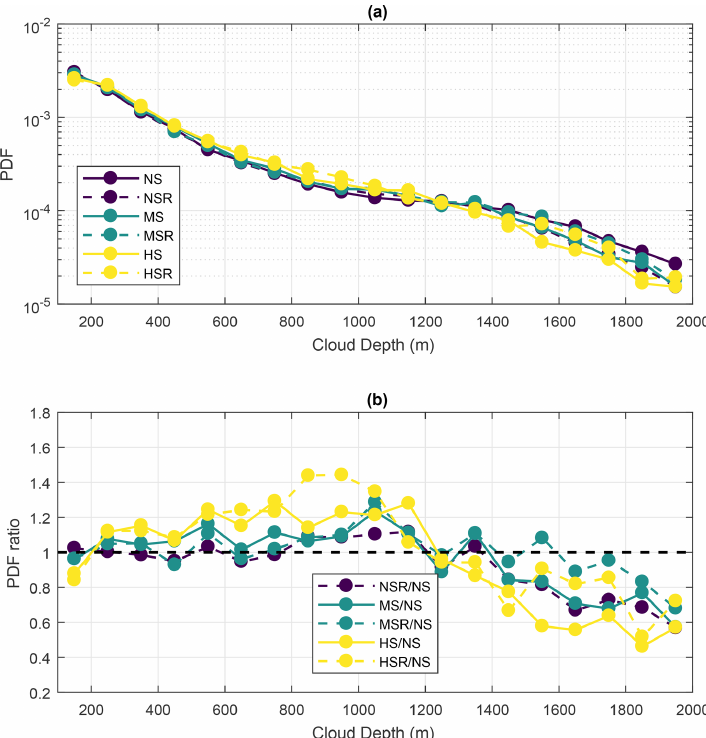
Figure 9. Same as Fig. 6 but for cloud depth. Cloud depth is calculated as the height difference between cloud top and cloud base (using the maximum and minimum height with LWC > 0 . 01gm − 3 ,